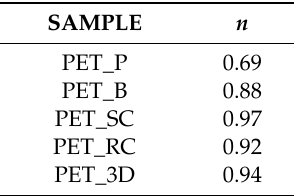
Figure 5. Viscosity curves and regression line on PET samples at 260 °C. Table 2. n index of samples obtained by power law.